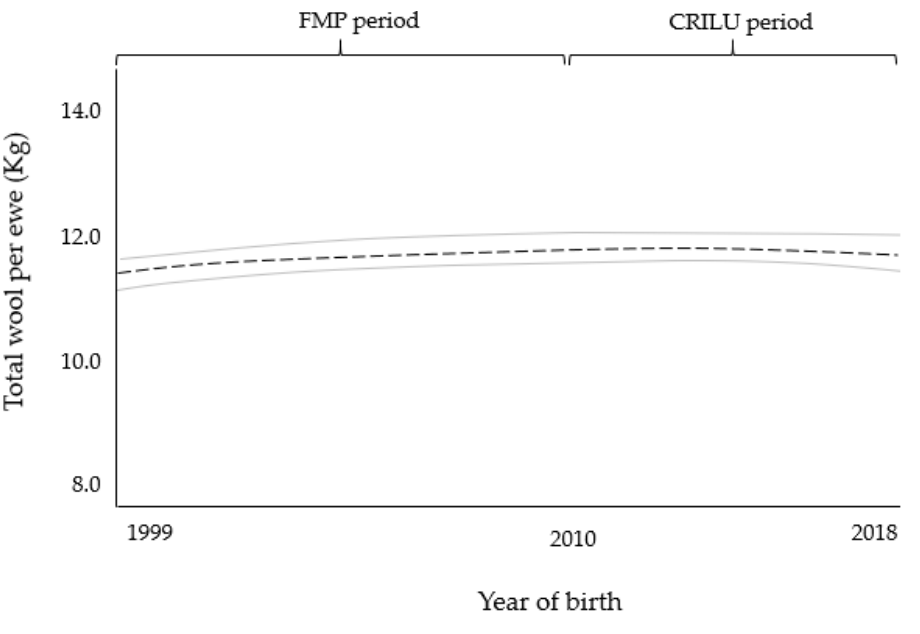
Figure 6. Mixed-age ewe phenotype trend for accumulative total wool production across all lambing opportunities (1–8) per year of birth (1999–2018) using a second-degree polynomial regression. Lambing opportunities correspond to the number of mating seasons each ewe had over her lifetime.